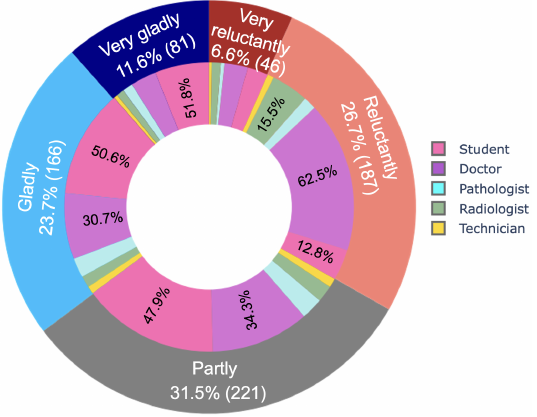
Figure 8. Affinity towards digitalization.